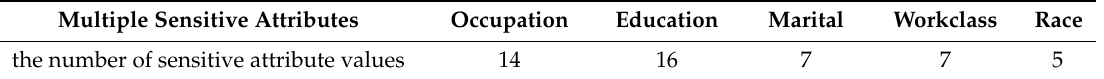
Table 2. Multiple sensitive attributes of the microdata.